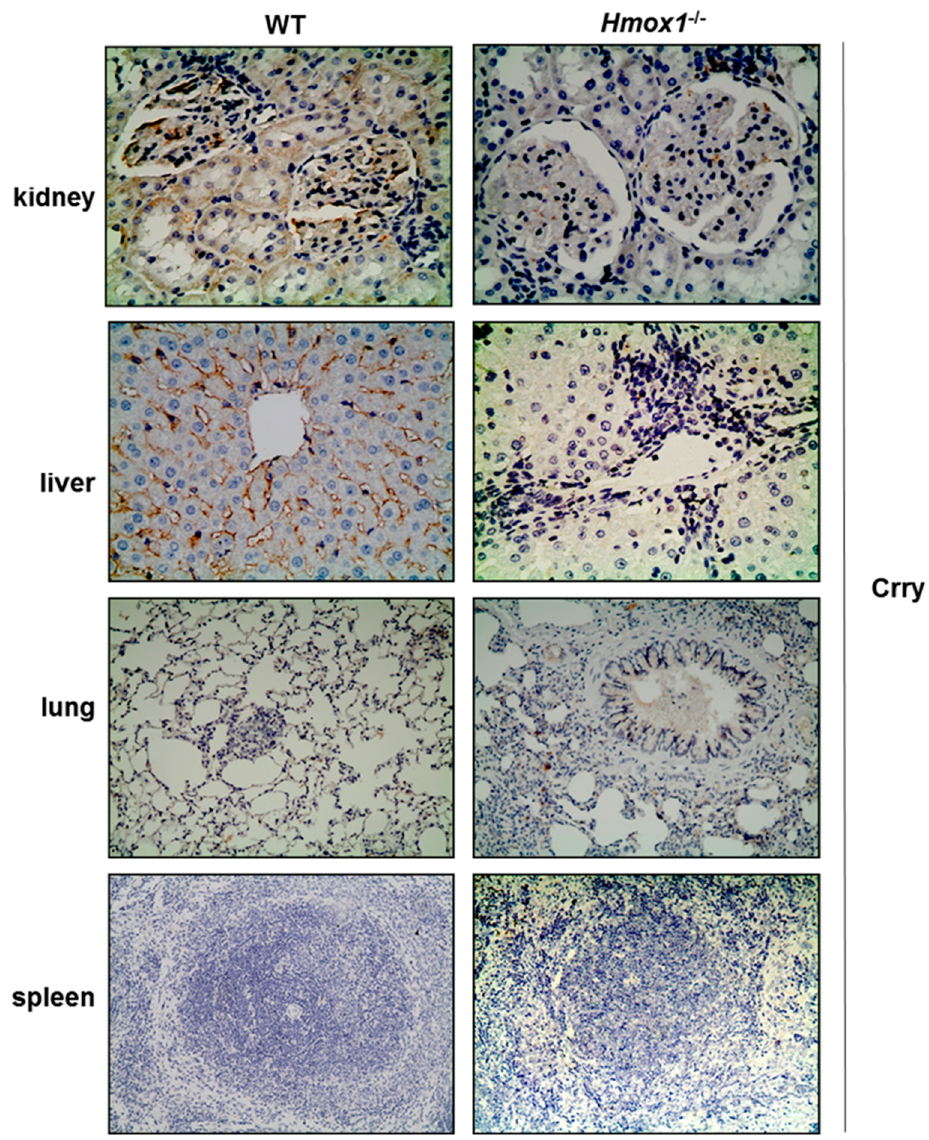
Figure 2. Crry immunostaining of tissues obtained from WT and Hmox1 − / − rats. Crry was detected in all tissues apart from spleen. Reduced Crry protein staining was demonstrated in kidney, liver and lung tissue section with no apparent changes in spleen tissue sections. Magnification ×200.